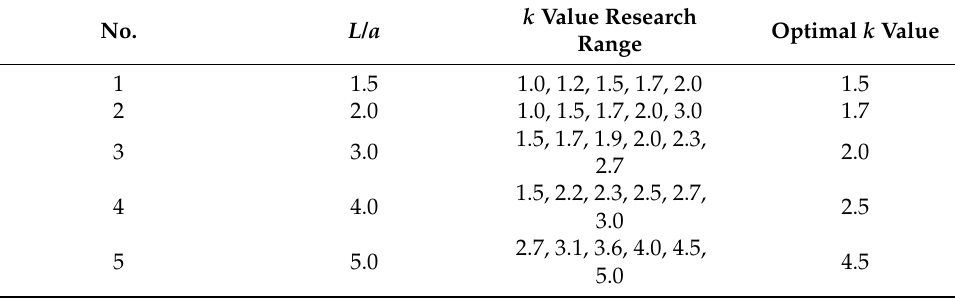
Table 3. Results of the optimal k values studied at five different L / a